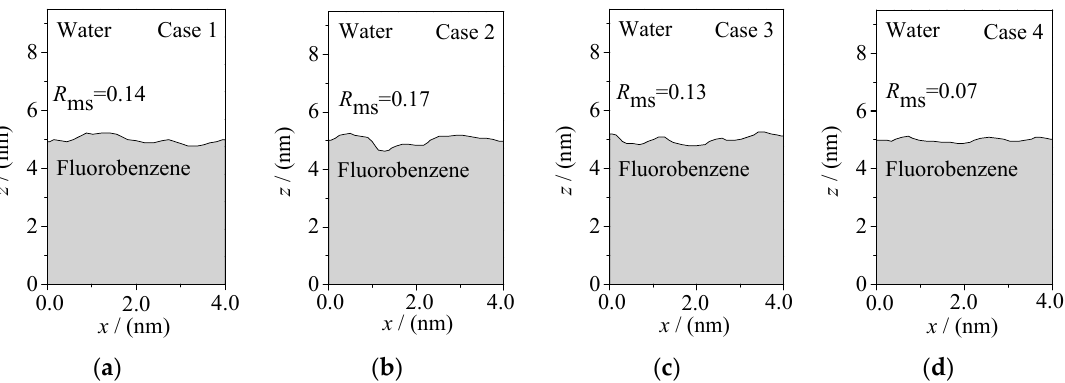
Figure 6. Interface morphology of the fluorobenzene–NaCl aqueous solution system with different contrations of ions: ( a ) Case 1; ( b ) Case 2; ( c ) Case 3; ( d ) Case 4.